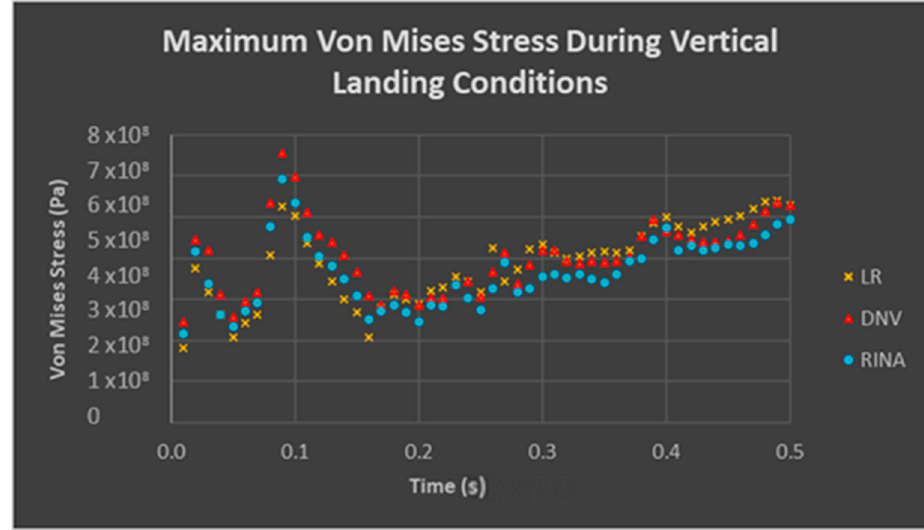
Figure 10. Maximum von Mises stress of the deck plate under the vertical landing condition.